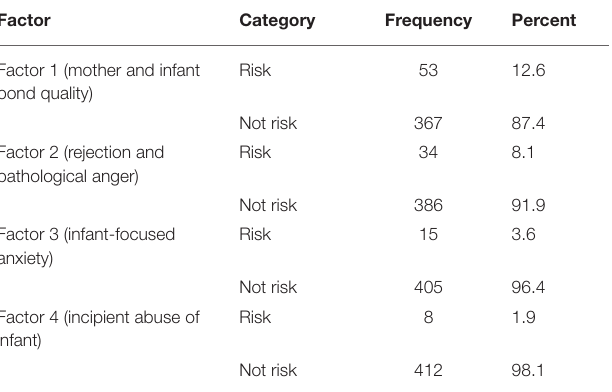
TABLE 5 | Mothers to infant postpartum bonding among postpartum mothers in Debre Tabor Town North West Ethiopia